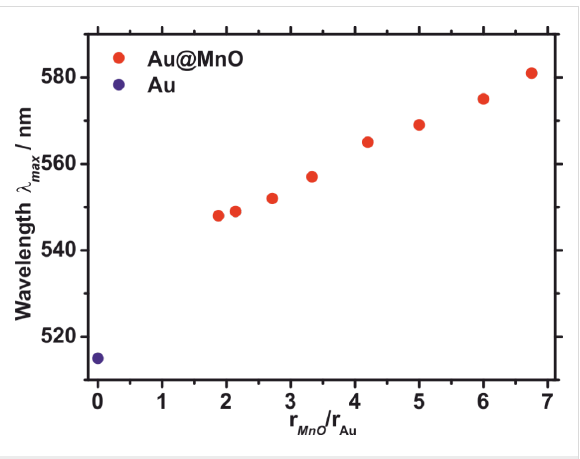
Figure 10: Domain size dependency of absorption maximum of Au@MnO nanoparticles determined by UV–vis spectroscopy in com- parison to pristine Au